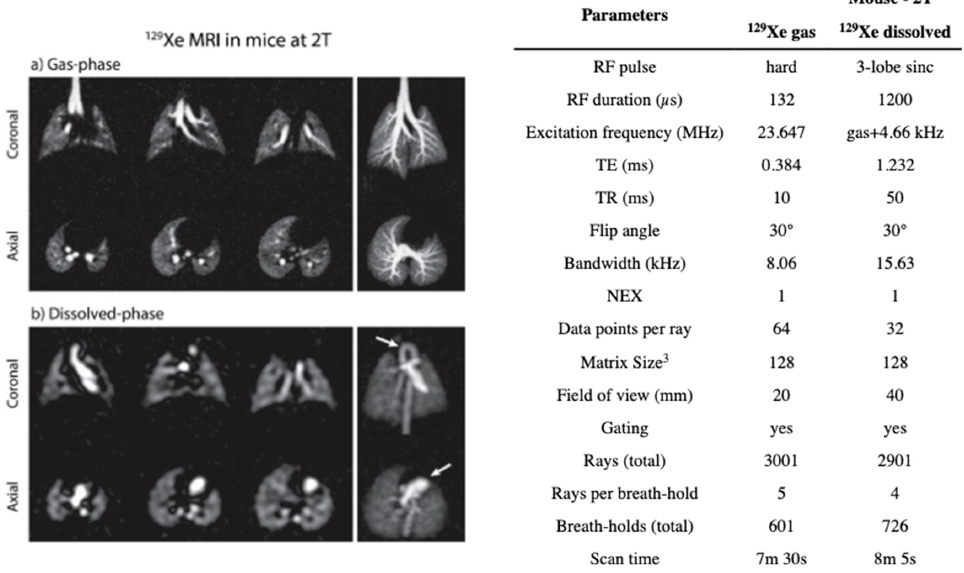
Figure 37. Gas-phase and dissolved-phase images in a mouse in vivo at 2 T. The white arrows denote visualized anatomical structures using dissolved HXe (aortic arch, top, and left ventricle, bottom). Reprinted with permission from Virgincar, et al. ( J. Magn. Reson. 2018, ref.